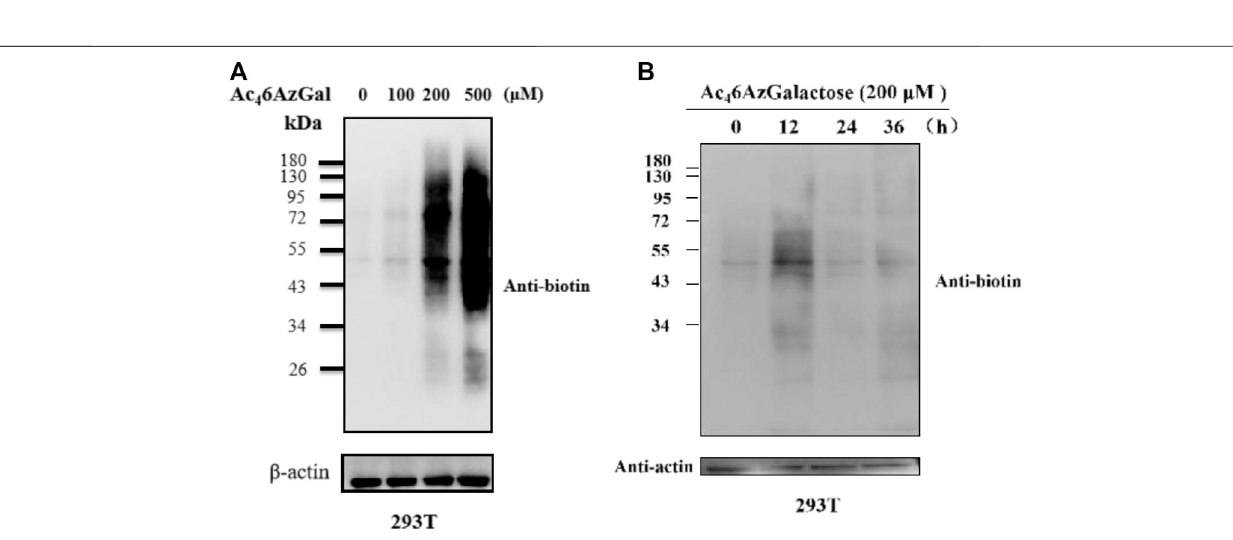
Frontiers in Chemistry |